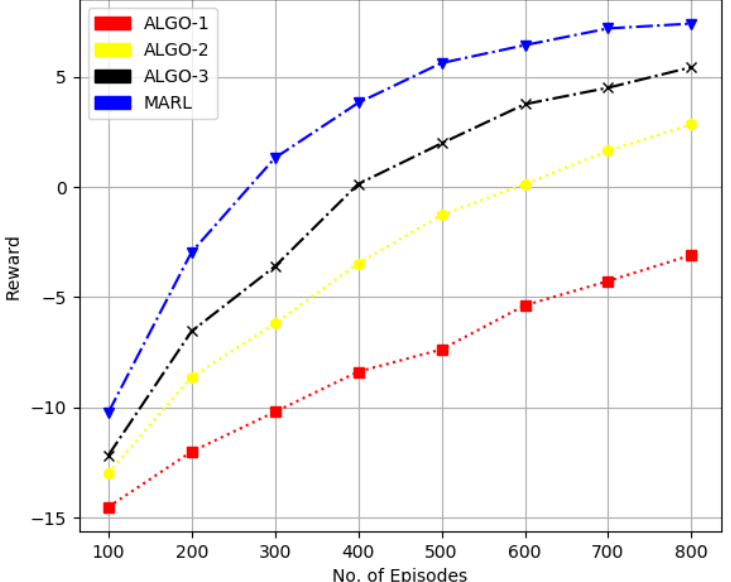
Figure 8. Performance comparison in terms of sumrate for 20 users, four receive antennas at BS and one transmit antenna at each